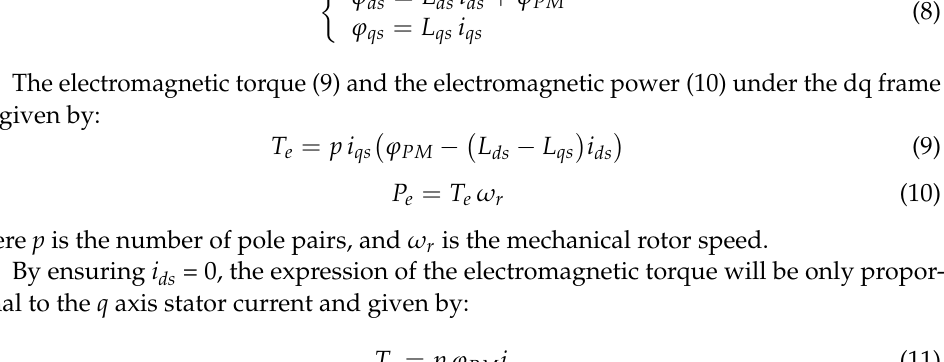
−  Figure 3. Fuzzy sets membership for inputs (e, ∆ e) and output ∆ U.